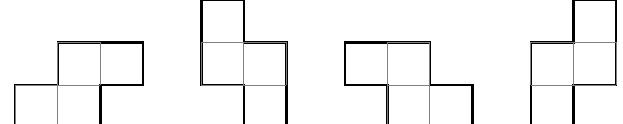
Figure 6. The 4 possible orientations of a tetromino P i .